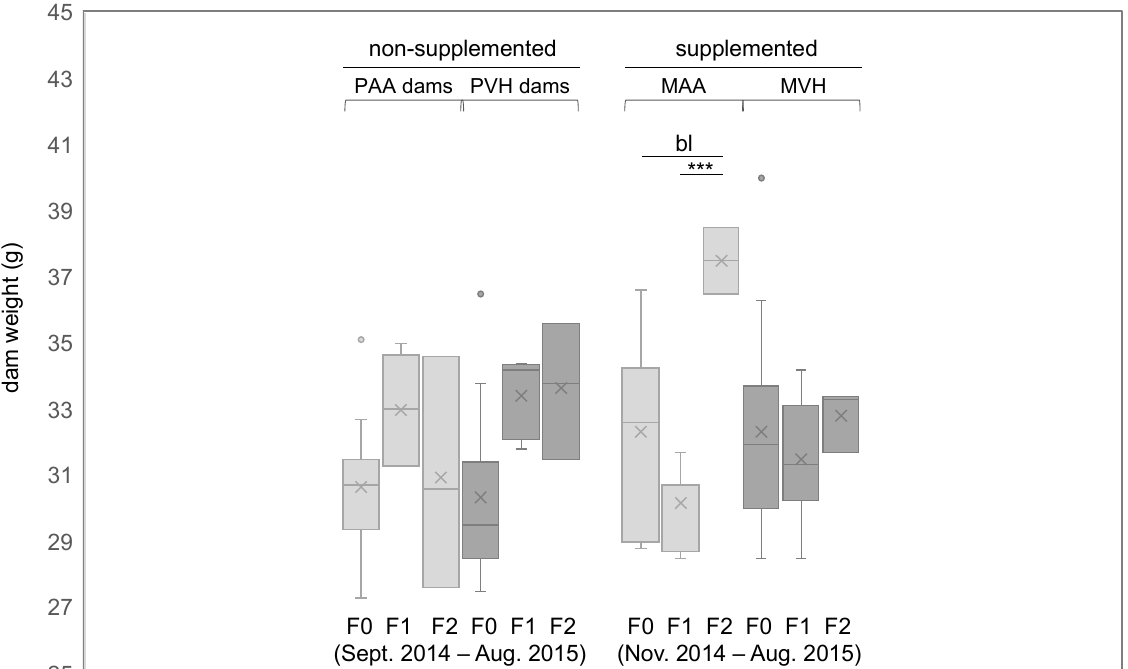
Figure 4. Body weight of three-month-old dams at supplemental day 1. Y-axis indicates dam body weight at supplemental day 1: day 1 of pregnancy. PAA and PVH dams: non-supplemented dams that were crossed to AA- or VH-supplemented sires. bl p < 0.1, *** p < 0.001. Other symbols are as in Figure 3. Table 1. Correlation between offspring body weight and AA or VH exposure across generations. Offspring Tissue Exposed All